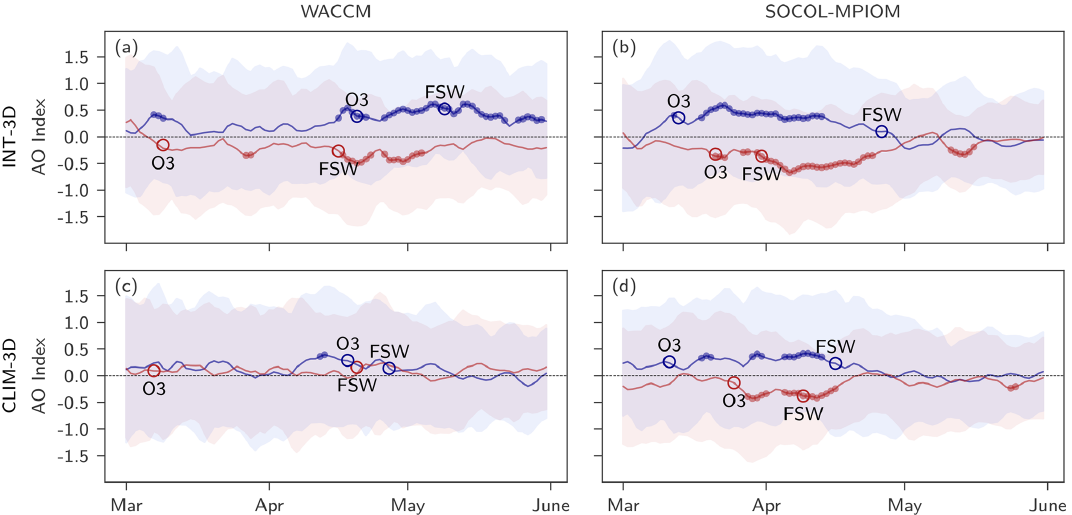
Figure A4. AO evolution in high- and low-ozone springs. Evolution of the Arctic Oscillation in the 25% of springs with the lowest (blue) and highest (red) ozone concentrations in WACCM (first column) and SOCOL-MPIOM (second column) in INT-3D (a, b) and CLIM-3D (c, d) . Dots mark days where the AO is significantly different from zero on a 5% level based on a Student’s t test. Shaded areas show the standard deviation across high- and low-ozone years. Circles mark mean ozone maximum and minimum dates and mean FSW dates in high- and low-ozone